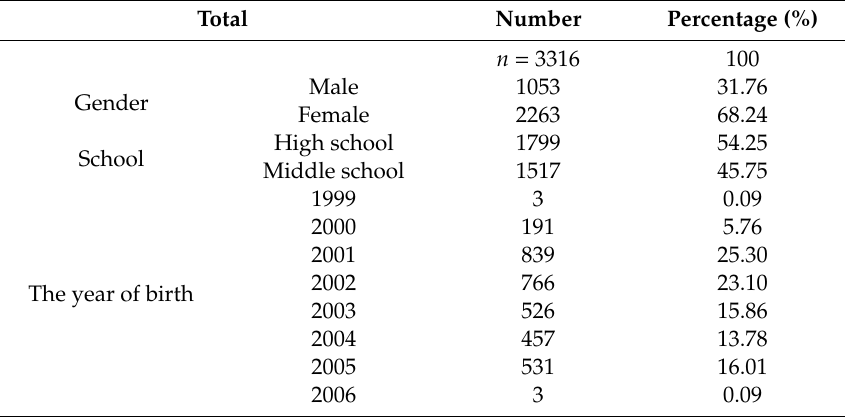
Table 2. The demographic information of